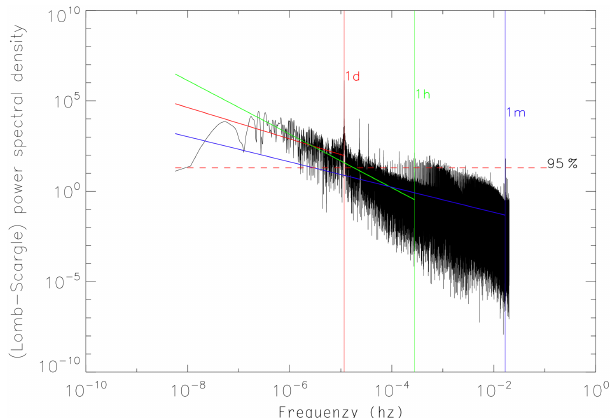
Figure 4. Spectral analysis for data shown in previous figures. Fa- miliar timescales are indicated by vertical dotted/dashed lines. Fit- ted scaling exponents are shown by coloured lines. The horizontal dashed line indicates the 95% confidence